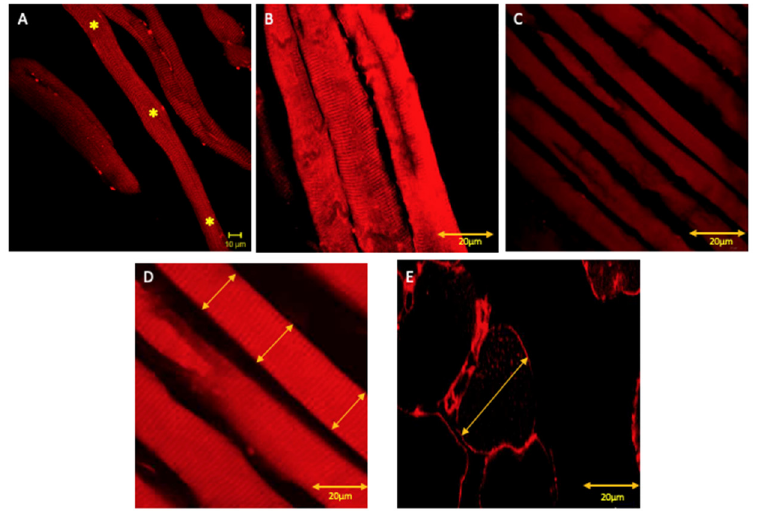
Figure 1. Compound panel of immunofluorescence reaction anti gamma sarcoglycan (red channel) (*where the measurements were taken). Pictures show that all tested muscles express gamma sarcoglycan, although the contralateral masseter fibers ( B ) show an increased staining pattern for gamma sarcoglycan compared to the control ( A ) and ispilateral muscles ( C ). Stars mark the top, middle and bottom diameters; the yellow arrows in ( D ) and ( E ) show how the diameter and the cross-sectional area measurements were performed, respectively.